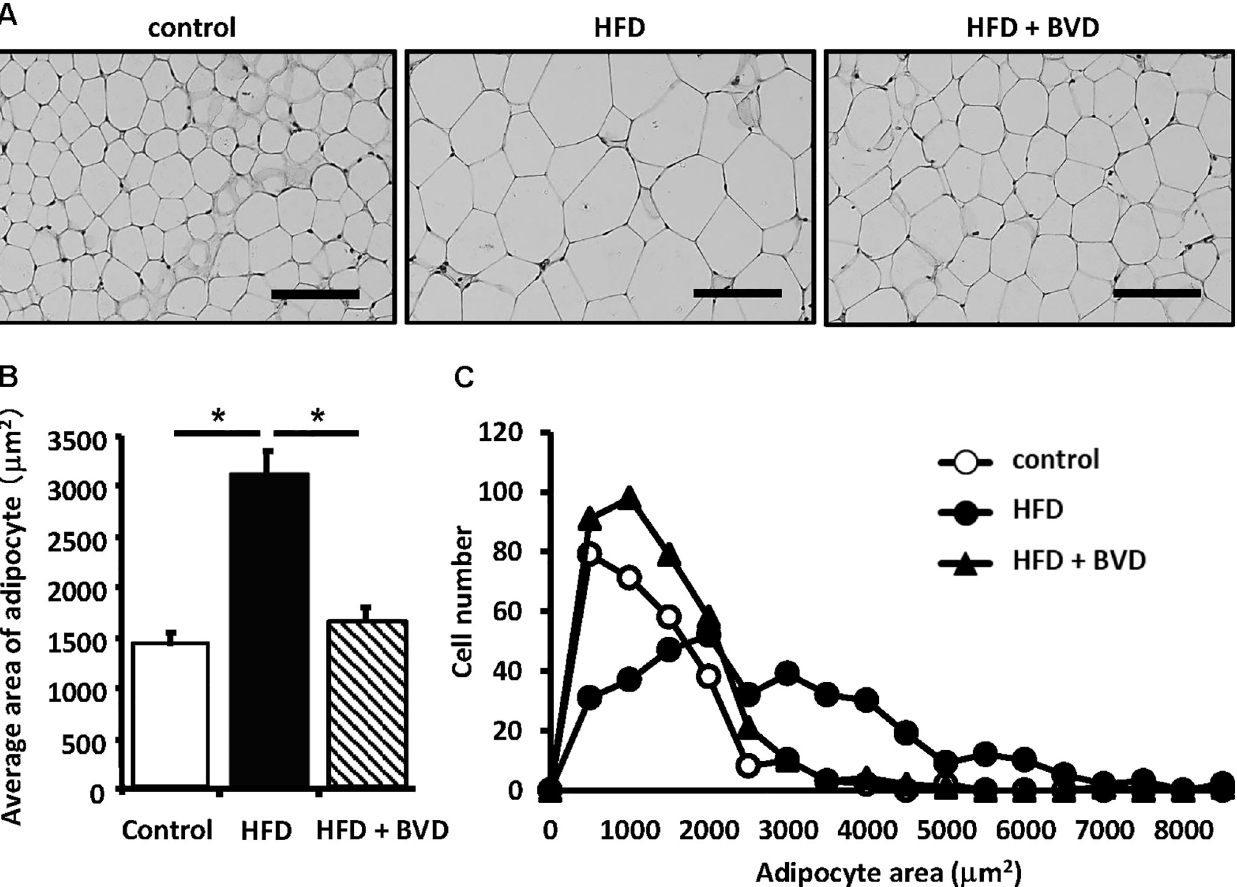
Fig 2. Effects of biliverdin (BVD) on adipocyte size. Representative photomicrographs (A), mean adipocyte area (B), and histogram of adipocyte area (C) derived from adipose tissue sections stained with haematoxylin and eosin. One hundred adipocytes per mouse were used for quantitative evaluation. Control mice ( � ), HFD mice ( ● ), and HFD mice treated with BVD ( ▲ ). Results are expressed as means ± SEM (n = 3). Scale bar, 100 μ m. Original magnification, × 200. � P < 0.01